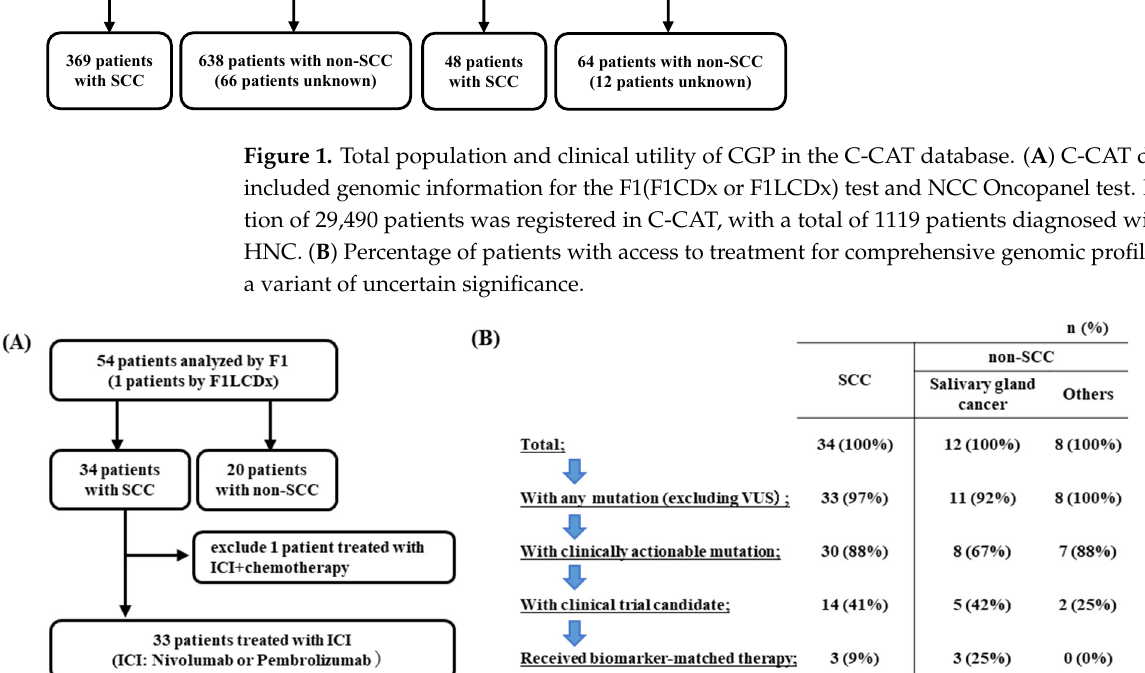
Figure 1. Total population and clinical utility of CGP in the C-CAT database. ( A ) C-CAT database included genomic information for the F1(F1CDx or F1LCDx) test and NCC Oncopanel test. Infor- mation of 29,490 patients was registered in C-CAT, with a total of 1119 patients diagnosed with R/M HNC. ( B ) Percentage of patients with access to treatment for comprehensive genomic profiles. VUS, a variant of uncertain significance.